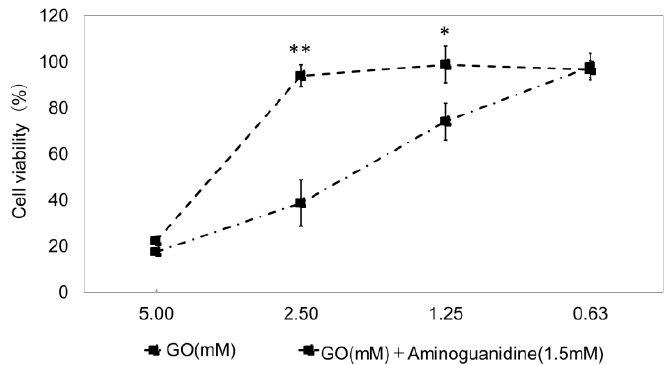
Figure 6. Cell viability of cells exposed to glyoxal (GO) at 48 h of culture. Four glyoxal (GO) concen- trations of 5 mM, 2.5 mM, 1.25 mM, and 0.625 mM were studied, and their effects on cell viability are shown. n = 3. GO: Glyoxal (mM); aminoguanidine: positive control (1.5 mM). The bars represent the mean + SD; * p < 0.05; ** p < 0.01 versus GO; student t -test.